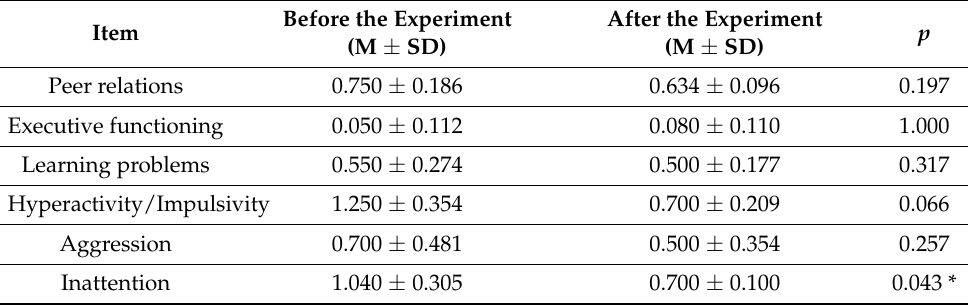
Table 3. The Conners Child Behavior Scores of the experimental group before and after the experiment.